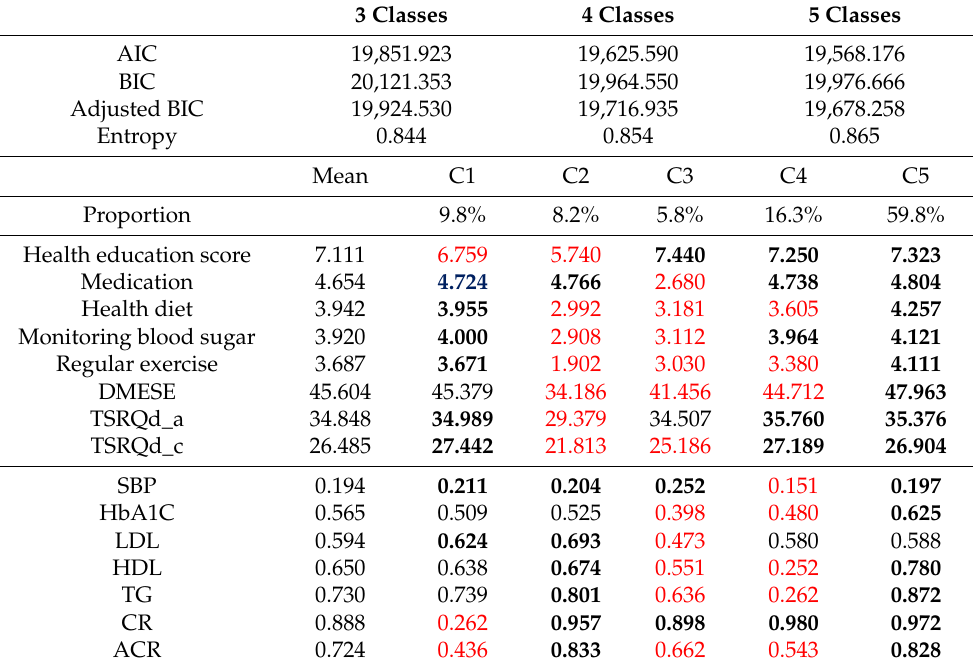
Table 1. Health profiles from LPA in the circulation indicators with information criteria.